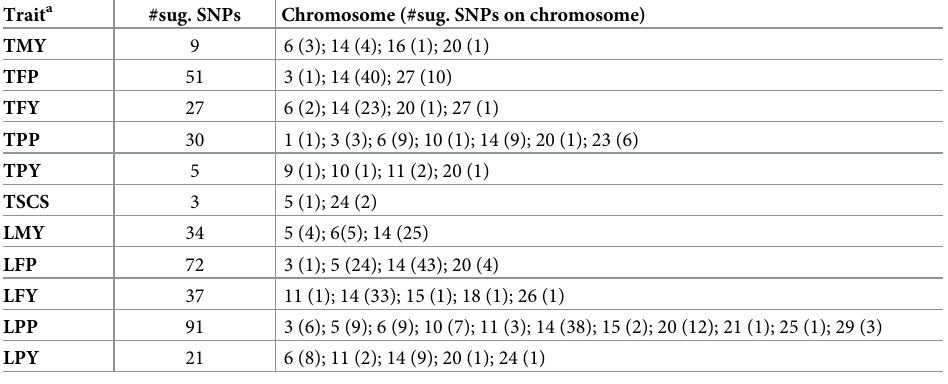
Table 3. Number of SNPs with suggestive main effects associated with milk production traits and somatic cell score. Trait